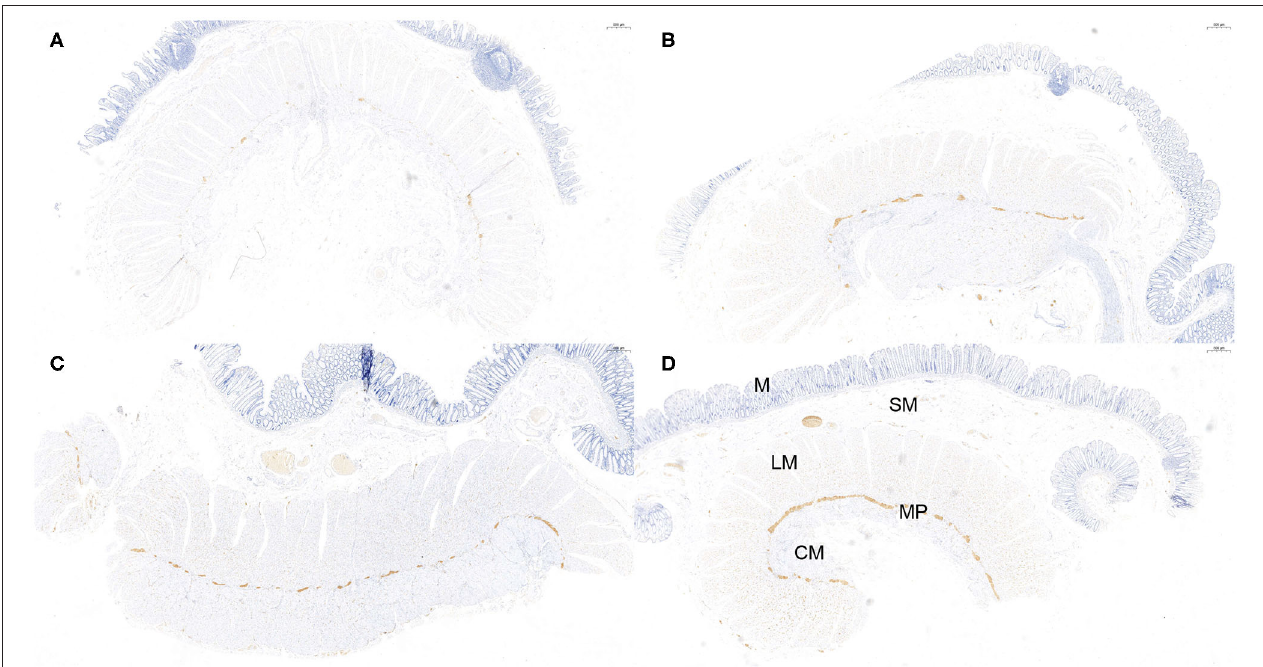
FIGURE 3 | Semi-quantitative counting for α -Syn expression in the myenteric plexus. All layers of the intestine were shown. From top to bottom: The mucosa (M), submucosa (SM), longitudinal muscularis (LM), myenteric plexus (MP), and circular muscularis (CM), respectively. The expression of α -Syn was defined as 1- sparse ( ≤ 1/4 positive staining area) (A) , 2- small amount ( ≤ 2/4 positive staining area) (B) , 3-common ( ≤ 3/4 positive staining area) (C) , and 4-rich ( > 3/4 positive staining area) (D) , according to a previous study. The “positive” stained area here refers to the length of the positively stained myenteric plexus as a proportion of the total length of the specimen. Hematoxylin counterstain, scale bars = 500 µ